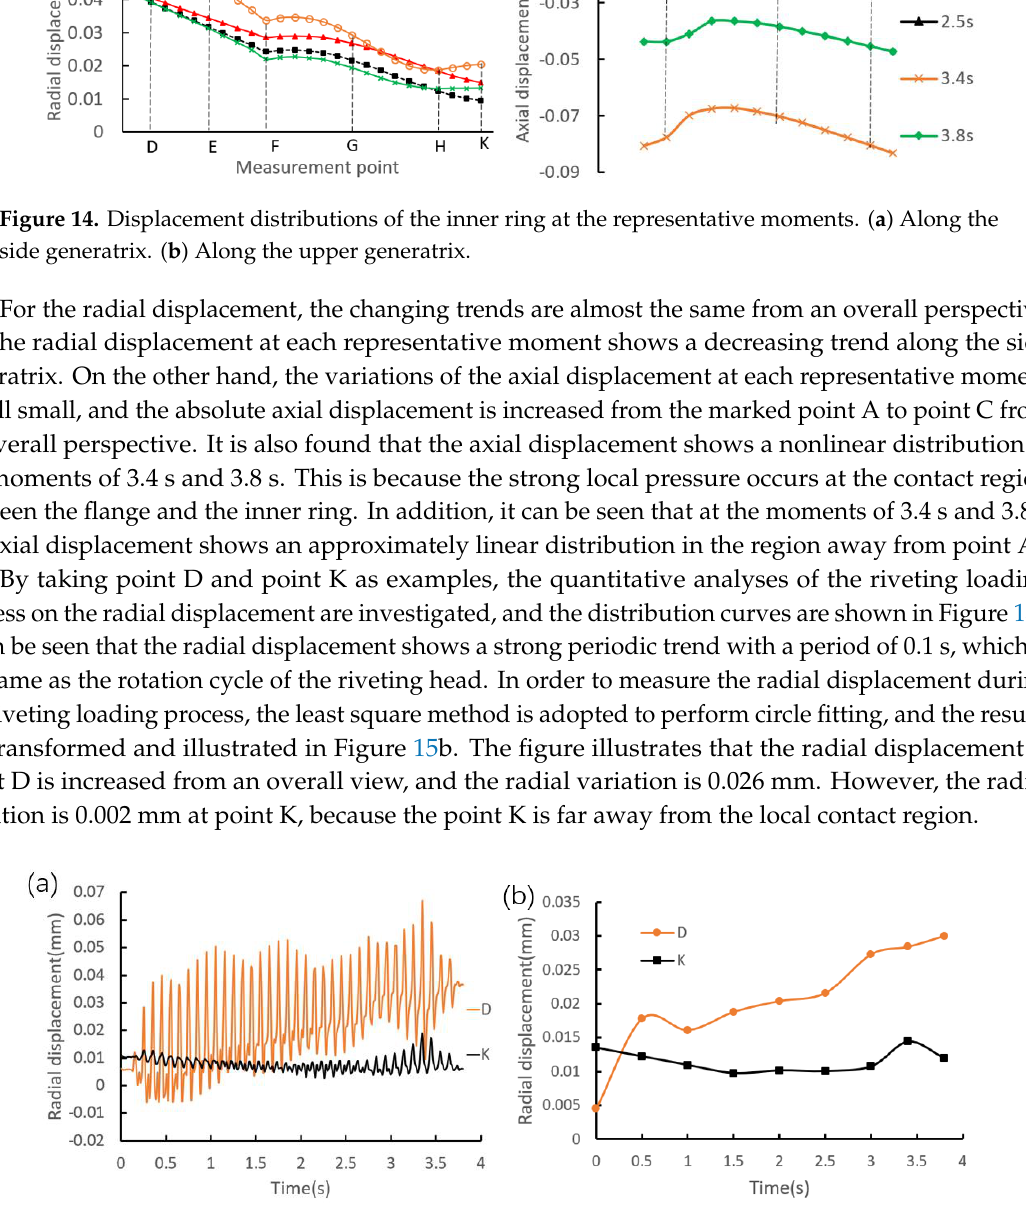
Figure 16. Periodic trend of the axial displacement at point D. On the other hand, by taking point C as an example, the quantitative analyses on the axial deformation are studied, and the distribution curve is given in Figure 17(a). It is found that the cycle period of the axial displacement is the same as the rotation cycle of the riveting head. In order to quantitatively measure the riveting loading process on the axial displacement, the average displacements along the circumferential points passing through point C are calculated and illustrated in Figure 17(b). It can be seen that the average displacement shows a decreasing trend from an overall view. Here it should be stated that, before the shaft end contacts with the round corner, the deformation of the inner ring is imposed by the radial swelling of the interference surface, which results in axial elongation of the inner ring. However, after the shaft end contacted with the round corner, the deformation of the inner ring is exerted mainly through the pressure imposed by the flange, which results in axial compression of the inner ring. Furthermore, in order to visualize the periodic trend of the axial displacement, Figure 18 shows the relationship of the axial displacement versus circumferential angle. It can be seen that in the process of riveting loading, the axial displacement shows an irregular deformation trend, and the minimum displacement is located at the local contact region. The reason is that the displacements at the rest of circumferential angles are generated in unconstrained state.